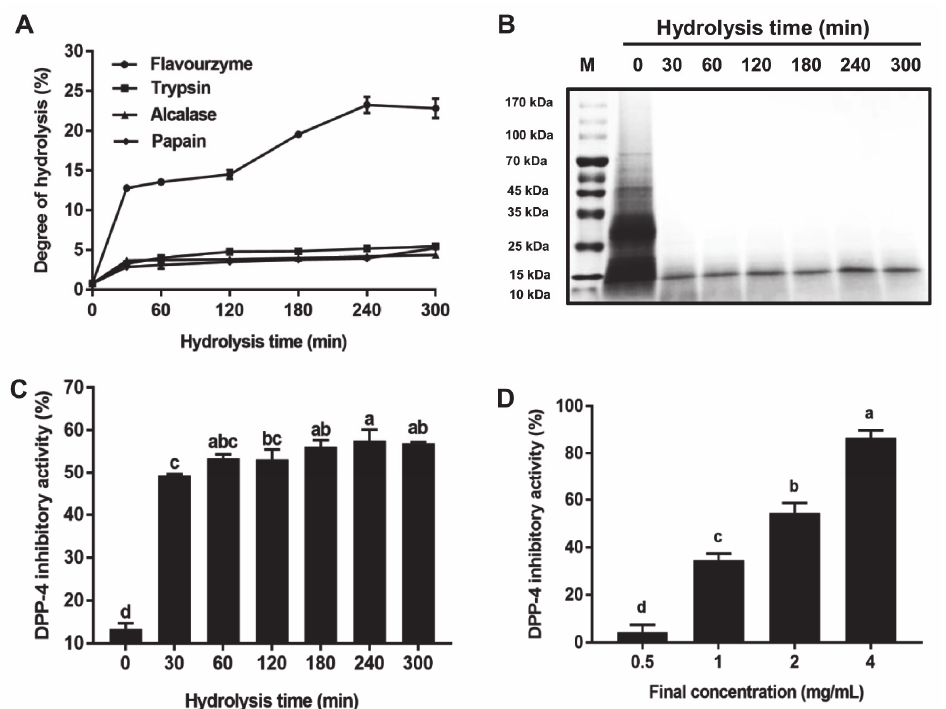
Figure 1. The degree of hydrolysis (DH) and inhibitory activity against dipeptidyl peptidase-4 (DPP-4) of Tenebrio (T.) molitor protein hydrolysates. ( A ) DH of T. molitor protein hydrolysates. ( B ) Sodium dodecyl sulfate-polyacrylamide gel electrophoresis (SDS-PAGE) analysis of T. molitor protein hydrolysates. ( C ) Inhibitory effect of T. molitor protein hydrolysates (at a final concentration of 2 mg/mL) on DPP-4 activity. ( D ) Inhibitory effect of 4-h flavourzyme hydrolysates (at different concentration) on DPP-4. Data are shown as the mean ± SD ( n = 3), and different letters mean significant difference ( p < 0.05).